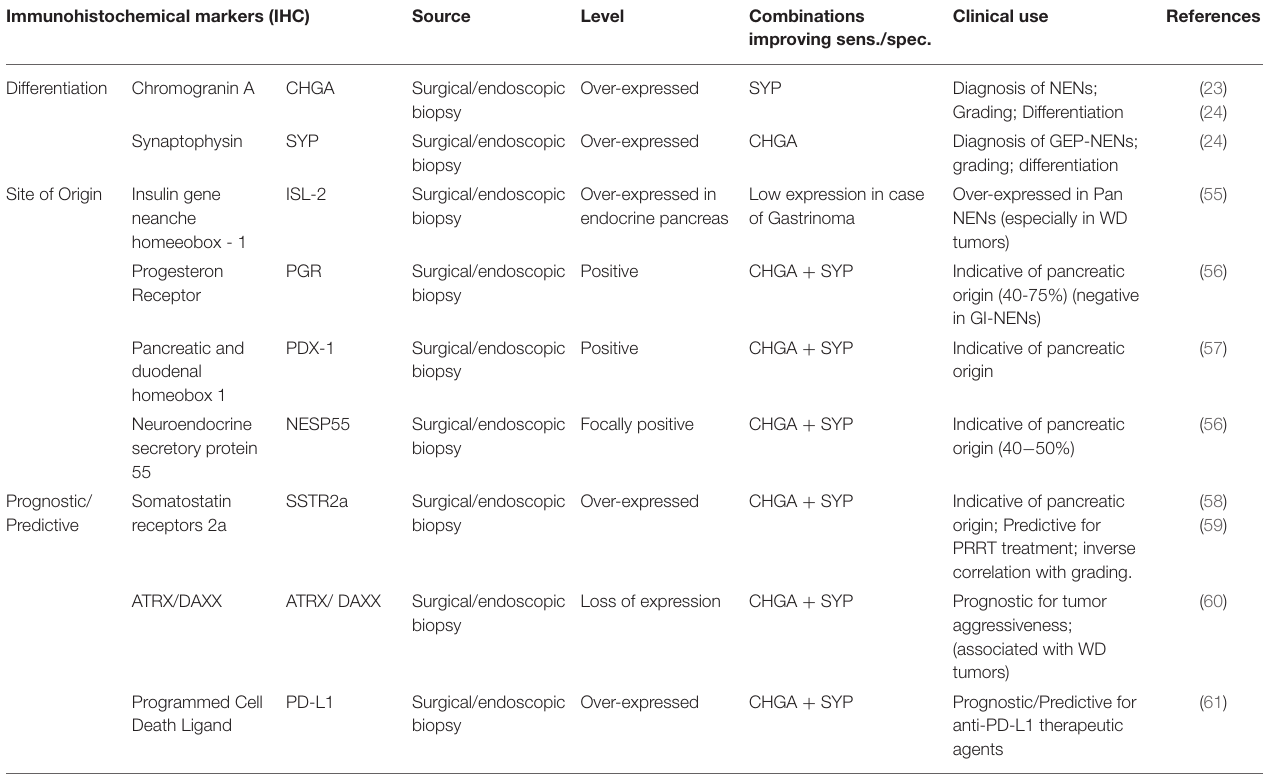
TABLE 3 | Immunohistochemical (IHC) biomarkers for PanNENs diagnosis, prognosis and treatment monitoring. Immunohistochemical markers